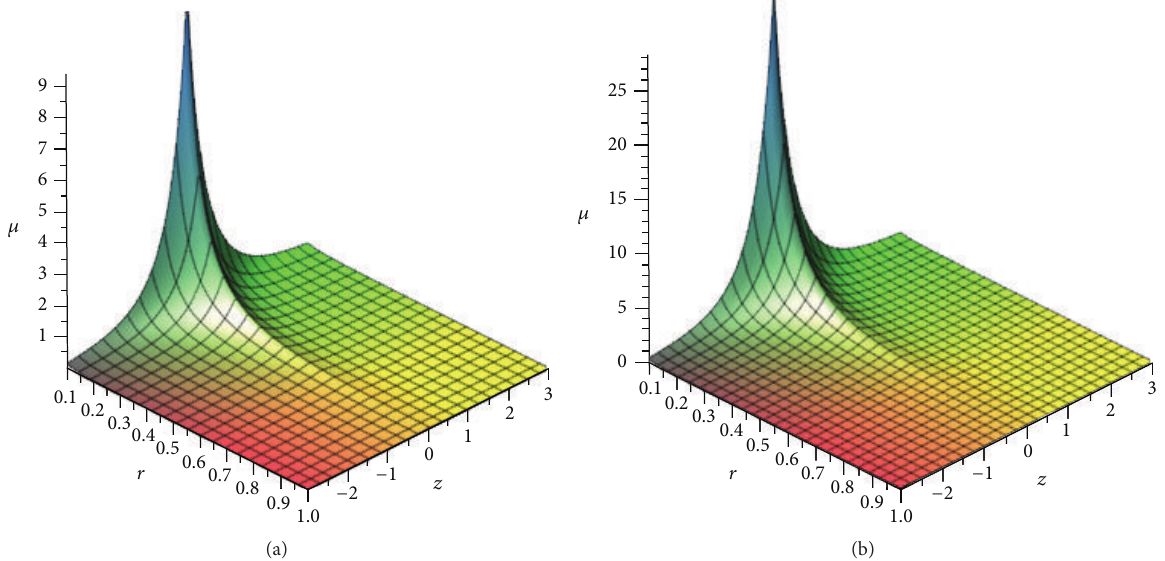
Figure 1: Surface plots of the energy densities (a) 𝜇 ± 0 and (b) 𝜇 ± 1 on the halo as functions depending on 𝑟 and 𝑧 with parameters 𝑎 = 𝑏 0 = 𝑏 1 = = 1 and 𝛽 = 0.75 . 𝑘 = 𝑘 𝜔